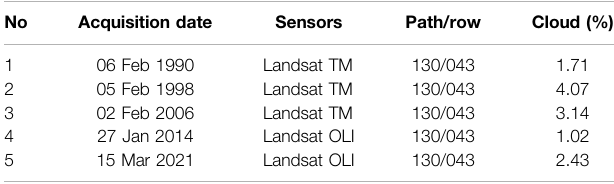
TABLE 1 | Satellite remote sensing impact data of Jianghan Plain from 1990 to